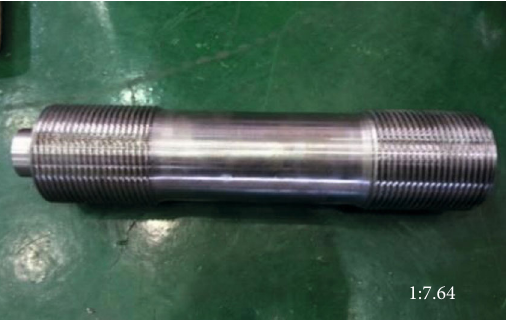
Figure 1: Stud bolt used in a low-pressure turbine of a power